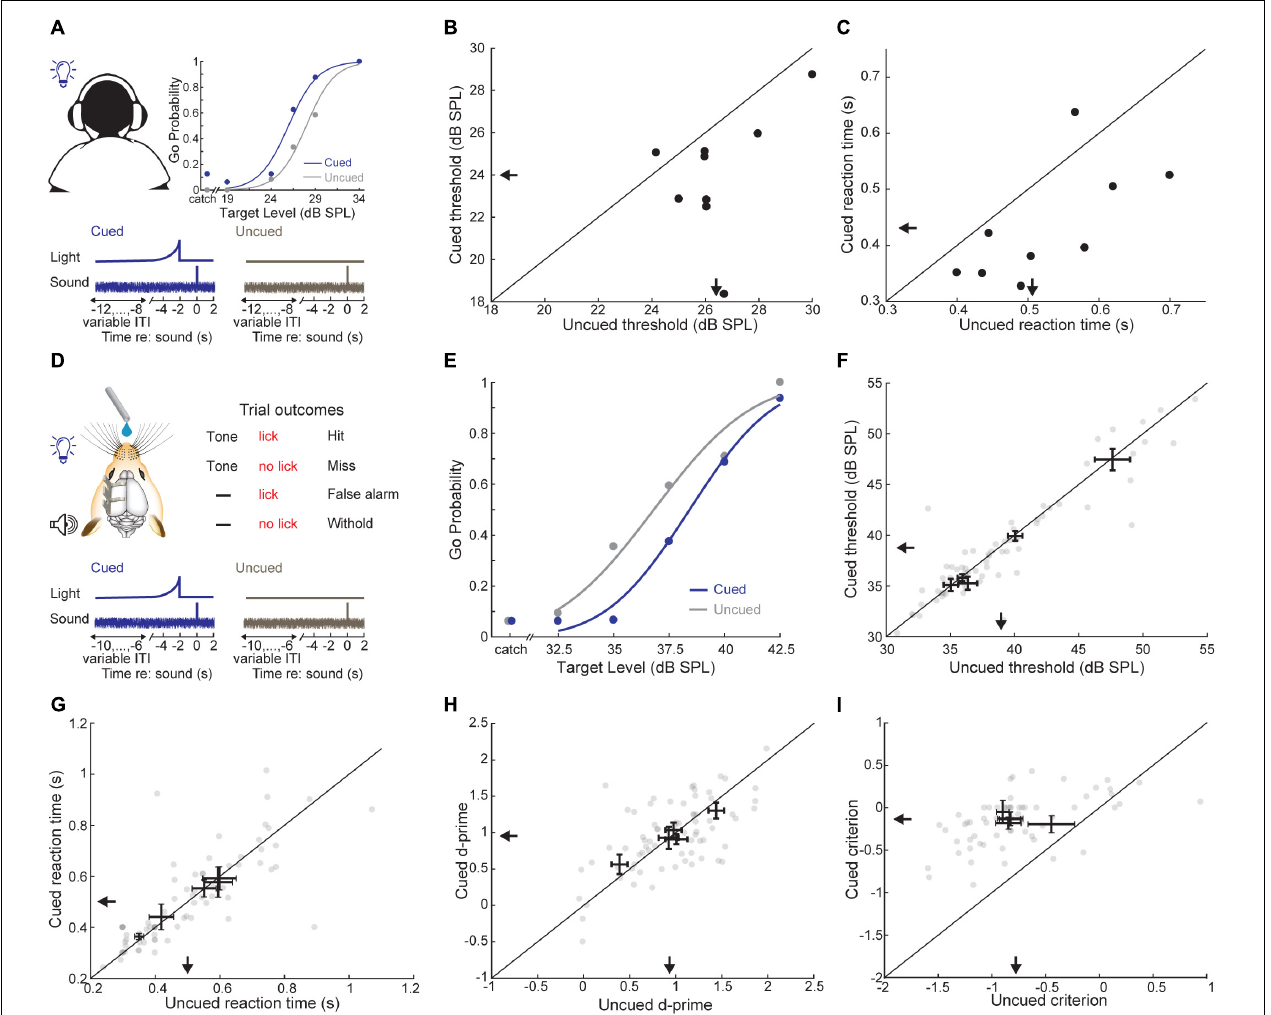
FIGURE 2 | A predictive visual cue decreases tone-in-noise detection thresholds and reaction times in humans, but not mice. (A) Schematic of the visually cued tone-in-noise task in human listeners with example psychometric functions for one subject (top) and cue structure (bottom). ITI = inter-trial interval. (B) Visually cued and uncued 50% correct thresholds within a behavioral session. Each dot represents an individual subject. Arrows indicate group means. (C) Reaction times for visually cued and uncued hit trials. (D) Schematic of the visually cued tone-in-noise detection task in water-restricted, head-fixed mice. Trial structure was identical to the human task, except that mice received water rewards on hit trials. (E) Probability of a Go response as a function of tone intensity for a single representative behavioral session. Psychometric fits (lines) and actual performance (dots) are shown for visually cued (blue) and uncued trials (gray). In catch trials, the false alarm rate is determined by presenting the visual cue without the auditory target. (F) Visually cued and uncued 50% correct thresholds. Each gray dot represents a single behavioral session from one mouse. Bidirectional error bars show mean ± 1 S.E.M. visually cued and uncued thresholds for one mouse. Arrows indicate group means. (G) The sensitivity term, d-prime, for visually cued and uncued trials, plotted as in panel (F) . (H) The criterion term, c, for visually cued and uncued trials, plotted as in panel (F) . (I) Reaction time (i.e., time to first lick) for visually cued and uncued hit trials, plotted as in panel (F)